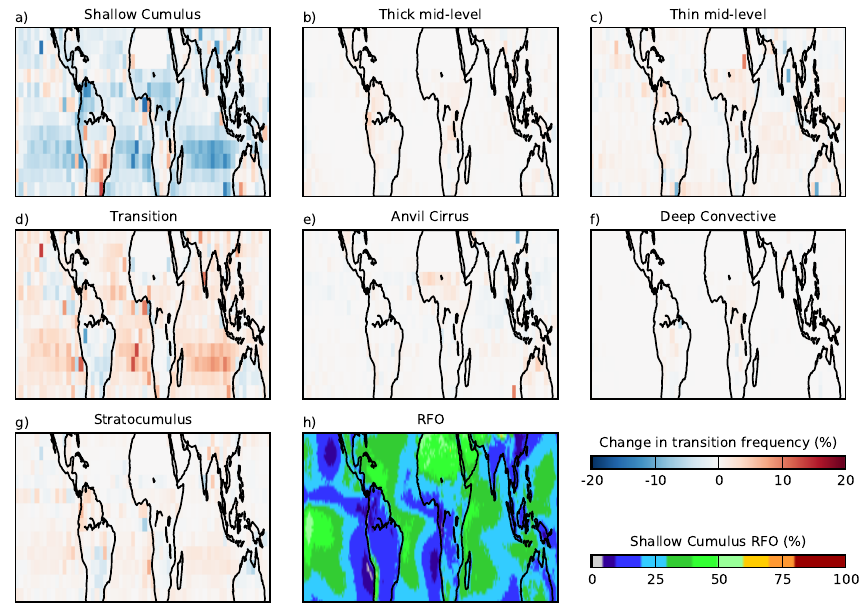
Fig. 4. Difference in transition frequency between the low and high AI populations for transitions from the shallow cumulus regime. These maps correspond to the first column of Fig. 3d. The relative frequency of occurrence of the shallow cumulus regime is shown in the final plot. These plots all use MODIS Aqua and Terra data from 2003–2011, between 30 ◦ N and 30 ◦